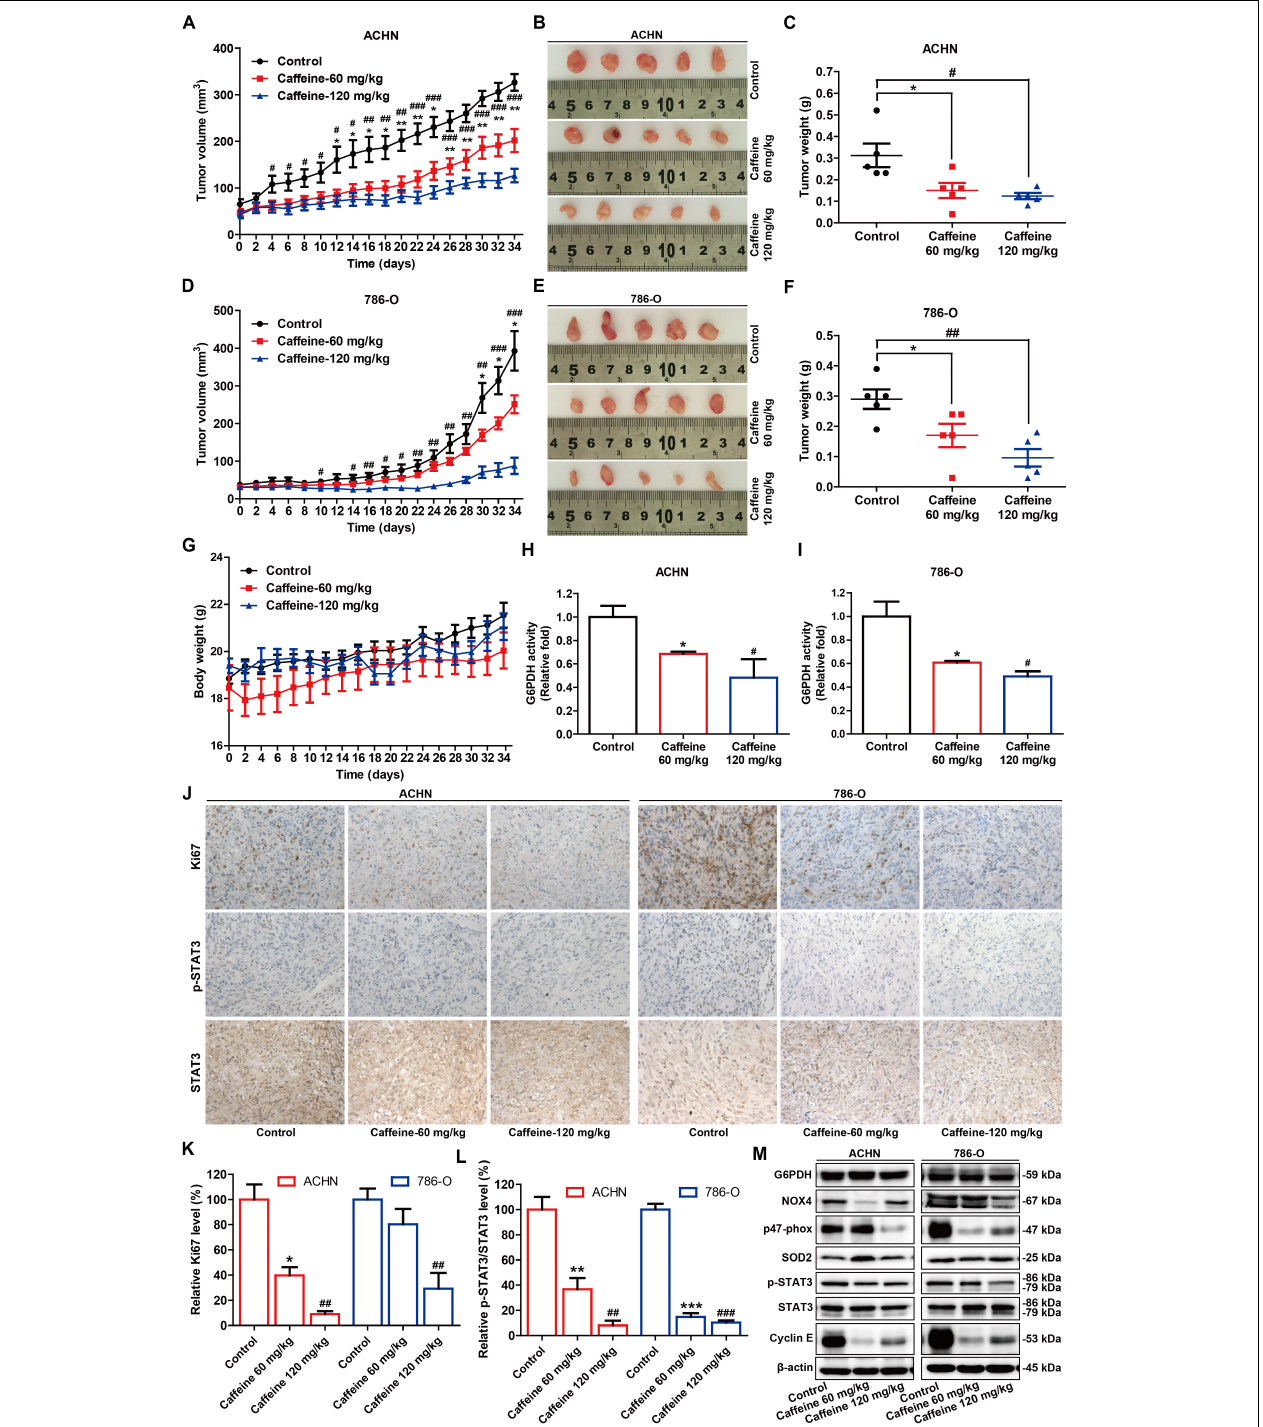
FIGURE 6 | Caffeine suppresses xenografted RCC development by inhibiting G6PDH activity in vivo . Caffeine treatment inhibits the tumor volume and tumor weight of ACHN (A–C) and 786-O (D–F) human RCC xenografts in nude mice, but does not affect the body weight (G) of these tumor-bearing mice. (H,I) G6PDH activity in xenografted ACHN (H) and 786-O (I) tumor tissues, as measured using a G6PDH Activity Colorimetric Assay Kit. (J) Immunohistochemical staining of ACHN and 786-O tumor tissue sections with antibodies against Ki67, p-STAT3, and STAT3 (original magnification × 400). The expression level of Ki67 (K) and the p-STAT3/STAT3 ratio (L) were analyzed using Image-Pro Plus 6.0 software. (M) Western blotting analysis of the xenografted ACHN and 786-O tumor tissues with the indicated antibodies. * P < 0.05, ** P < 0.01, and *** P < 0.001, low-dose caffeine group versus the control group; # P < 0.05, ## P < 0.01, and ### P < 0.001, high-dose caffeine group versus the control group. Representative images are displayed. Data are shown as means ± SEM of five mice per group.